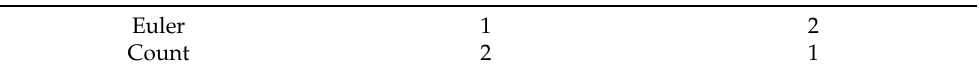
Table 7. First decomposition type—distribution of combinatorial Euler characteristics of Trian- gle3DNet objects from border interior overlay.